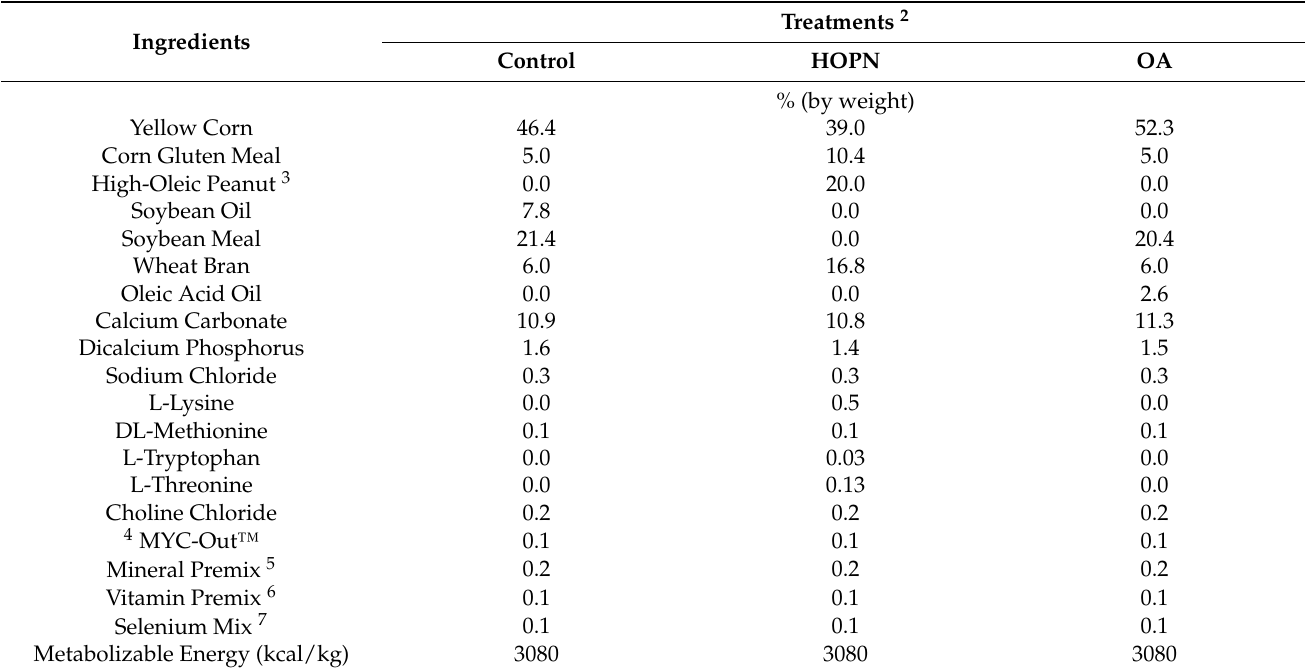
Table 1. Composition of formulated experimental laying hen diets 1